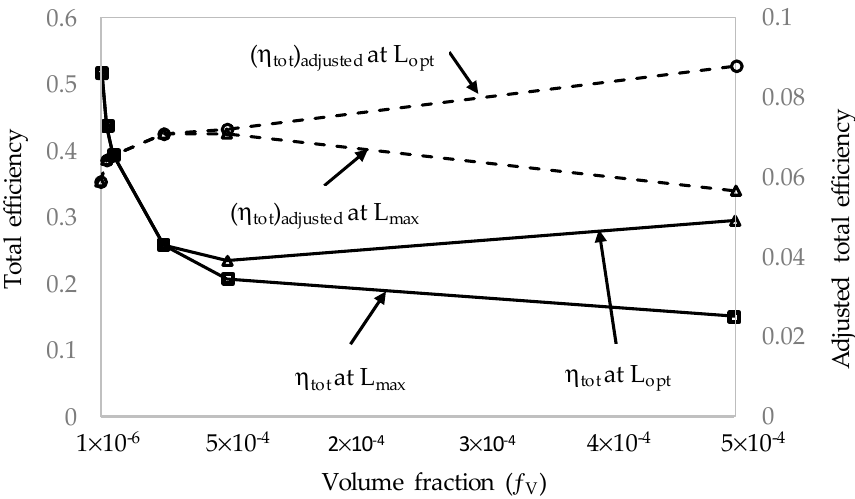
Figure 15. Comparison of total efficiency and total adjusted efficiency at a fixed peak temperature, T peak , for different volume fractions, f v , at maximum receiver length, L max , and optimum receiver length, L opt .